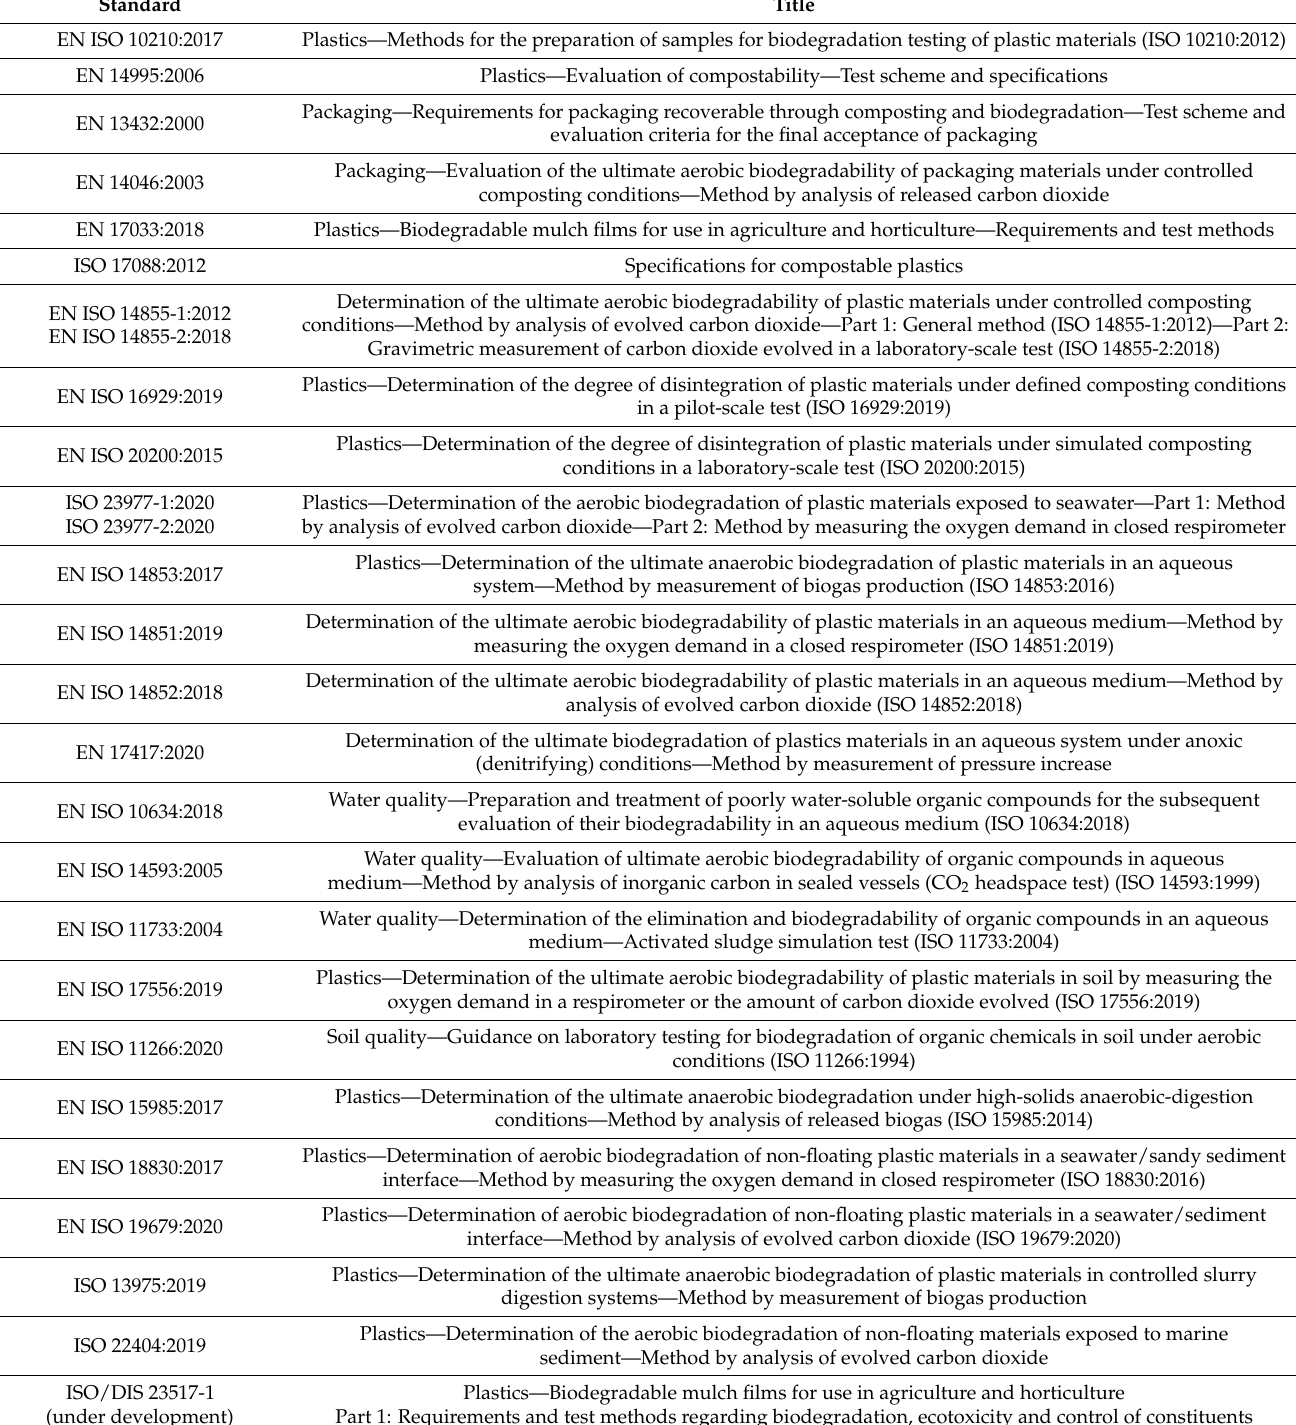
Table 3. Main ISO and CEN standards relating to biodegradability and compostability of